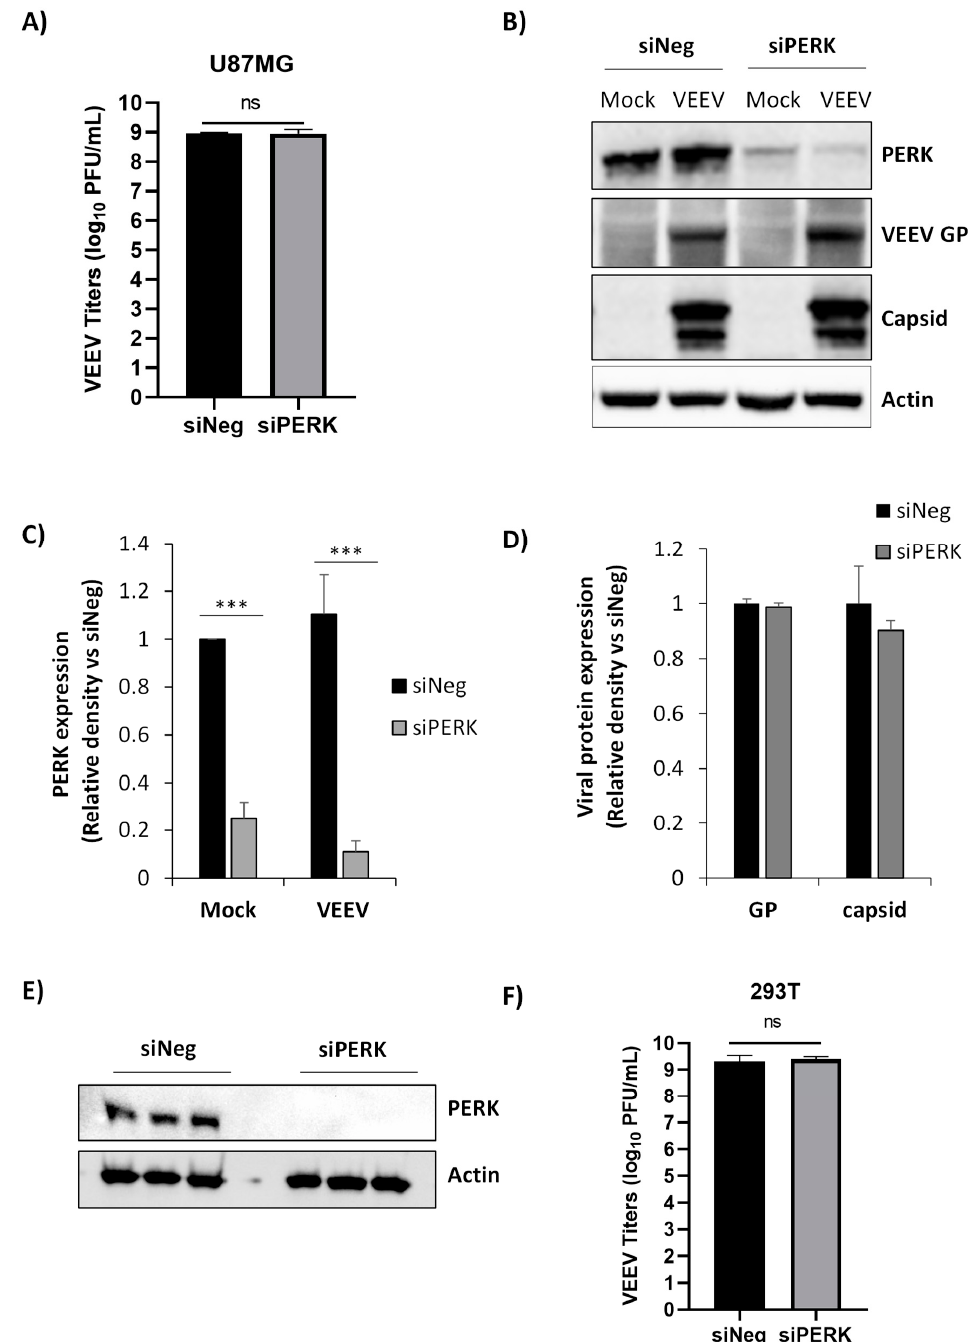
Figure 2. siRNA knockdown of PERK has no effect on VEEV replication in U87MG or 293T cells. U87MG cells were transfected with 100 nM of siNeg or siPERK siRNAs. At 48 h post transfection, cells were mock infected or infected with VEEV TC-83 (MOI 5). ( A ) Viral replication was analyzed via plaque assays using supernatants collected from U87MG cells at 16 hpi. N = 3, ns = not significant. ( B ) Cell lysates were collected at 16 hpi and analyzed by immunoblot. PVDF membranes were probed for levels of PERK, VEEV GP, and VEEV capsid. β -Actin was used as a loading control. ( C , D ) Data show the quantitation of the respective immunoblots. Protein levels expressed in each blot were normalized to β -actin and normalized values were calculated relative to siNeg-transfected cells. N = 3, *** p ≤ 0.001. ( E ) 293T cells were transfected with 100 nM of siNeg or siPERK siRNAs. At 48 h post transfection, cell lysates were collected and analyzed by immunoblot. PVDF membranes were probed for levels of PERK. β -Actin was used as a loading control. ( F ) 293T cells were transfected with 100 nM of siNeg or siPERK siRNAs. At 48 h post transfection, cells were infected with VEEV TC-83 (MOI 5). Viral replication was analyzed via plaque assays using supernatants collected at 18 hpi. N = 3, ns = not